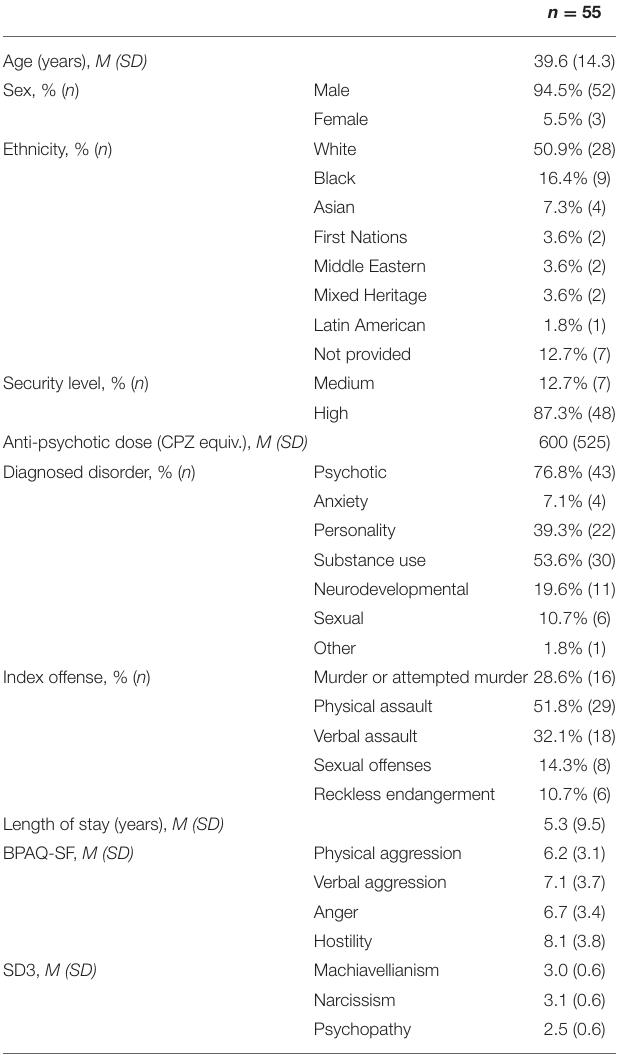
TABLE 1 | Demographic characteristics, BPAQ-SF, and SD3 mean